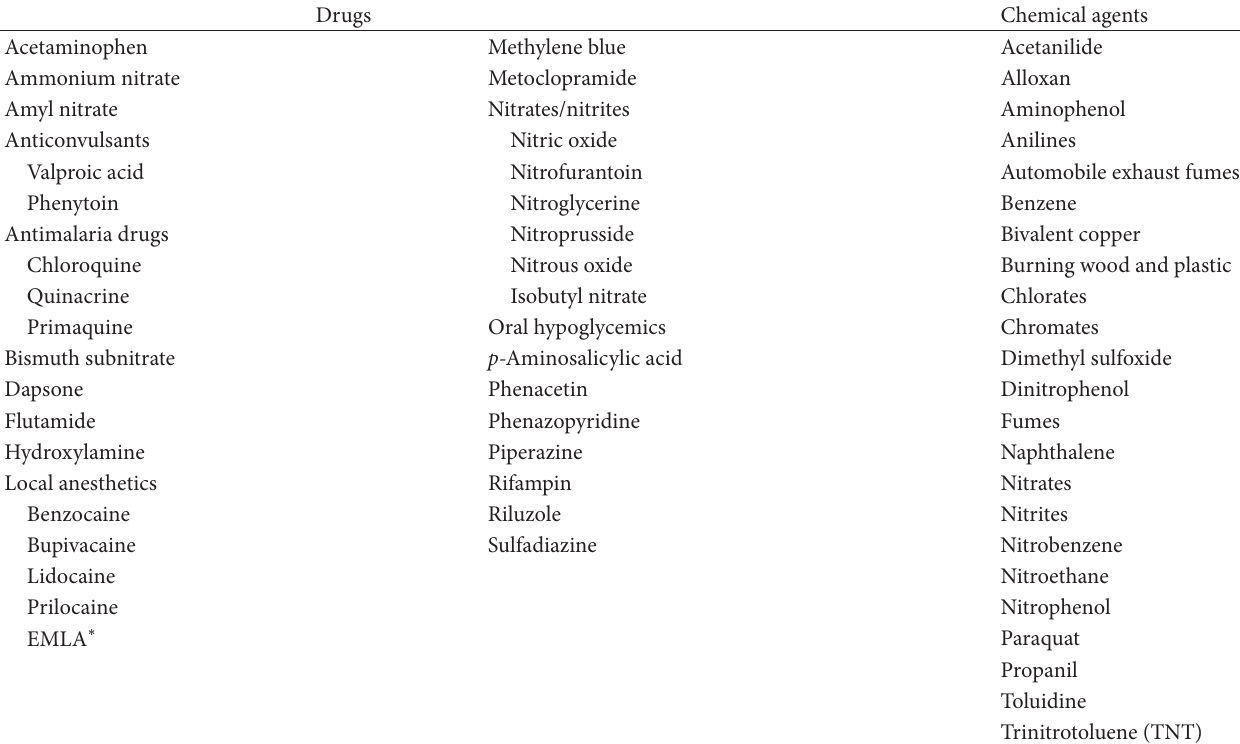
Table 1: Substances that can cause MetHb 1